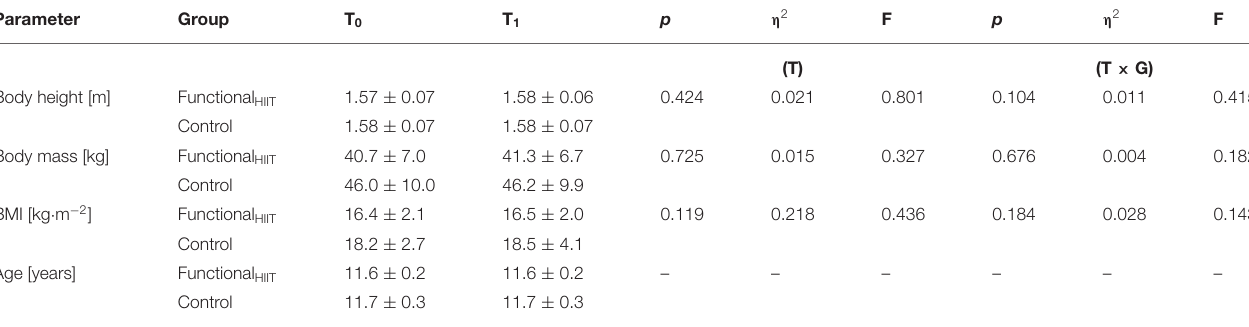
TABLE 1 | Anthropometric parameters (means ± SD) for the Functional HIIT ( n = 17) and control group ( n = 18) before (T 0 ) and after (T 1 ) the 4-week intervention. Parameter Group